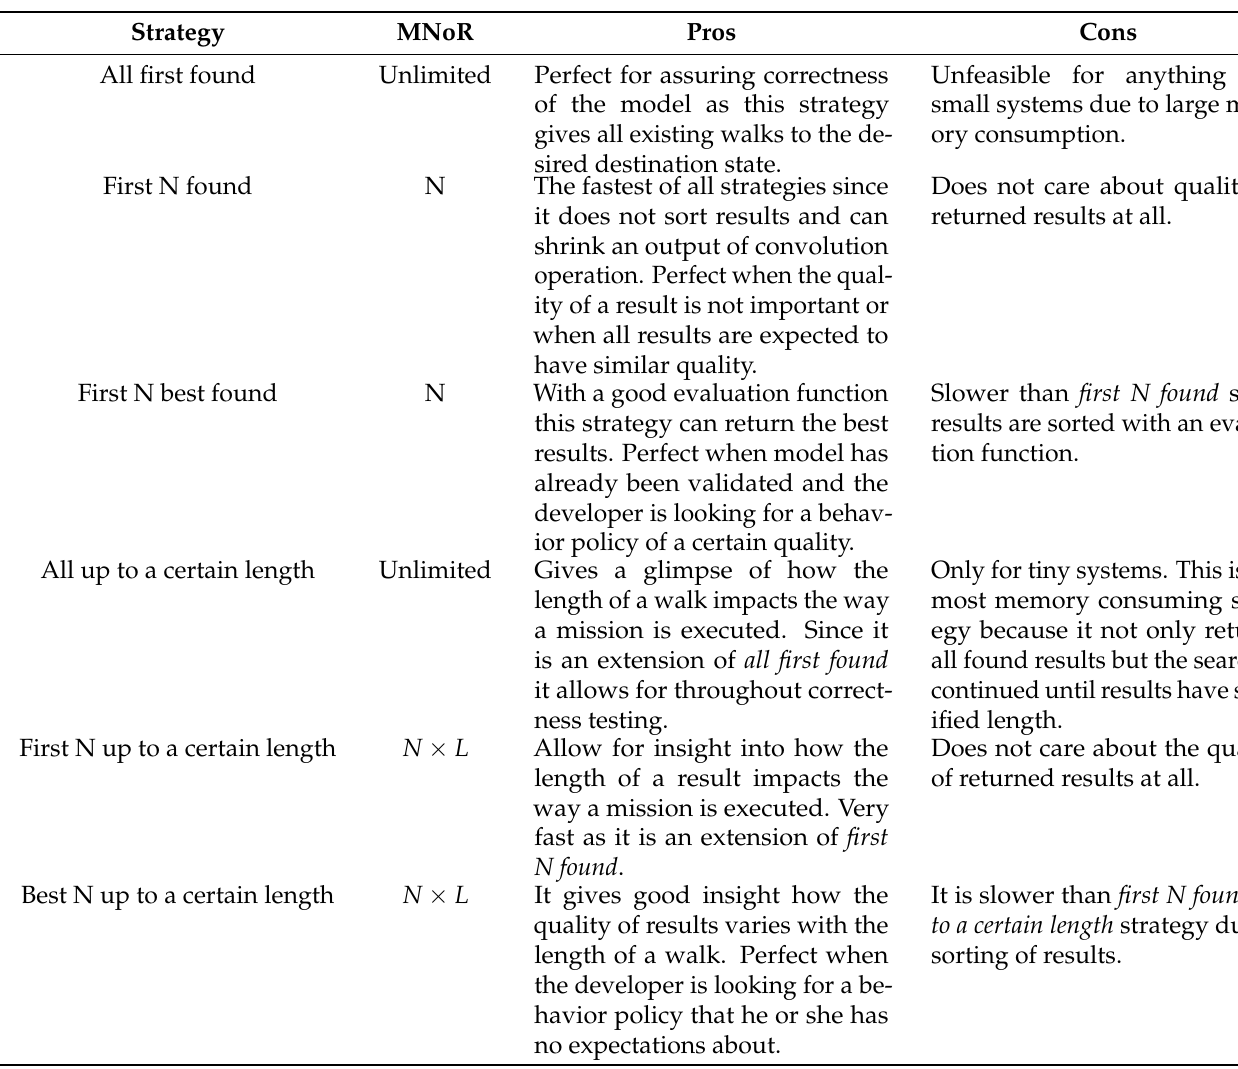
Table 22. Summary of the proposed strategies for finding walks in a state space. The second column denoted as MNoR stands for Maximum Number of Results. The value of N is equal to a number of results of the same length. The value of L is equal to the maximum length of a